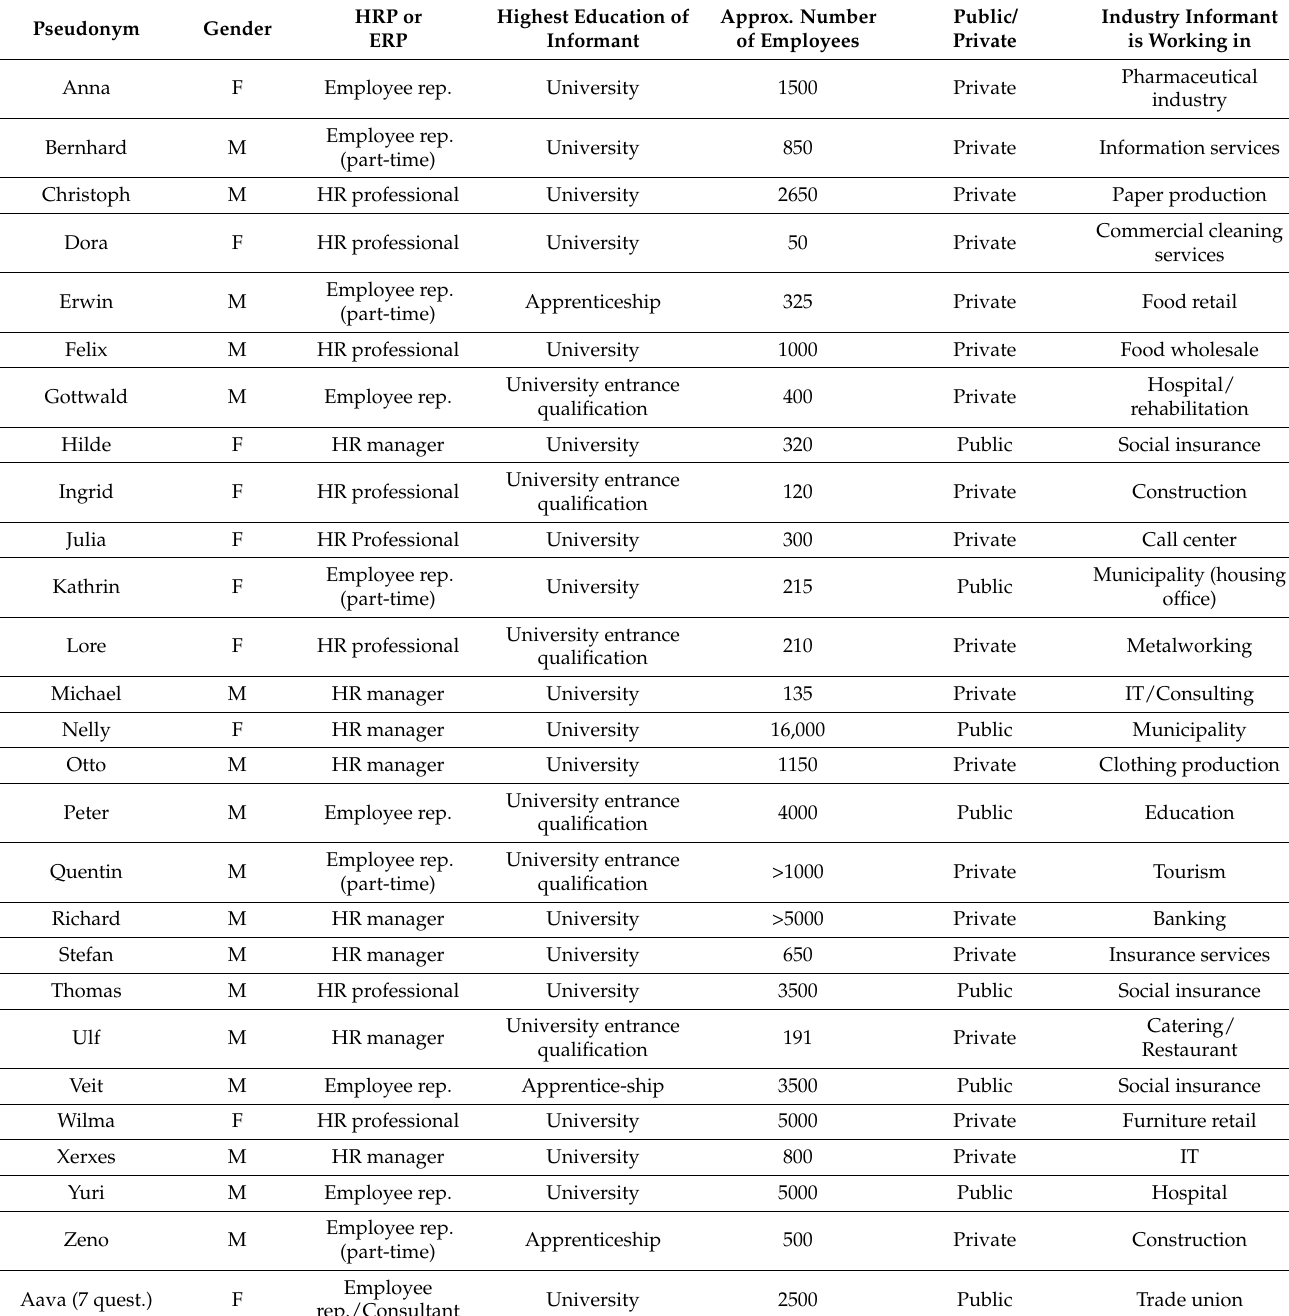
Table 1: Sample of interview partners. Table 1. Description of the